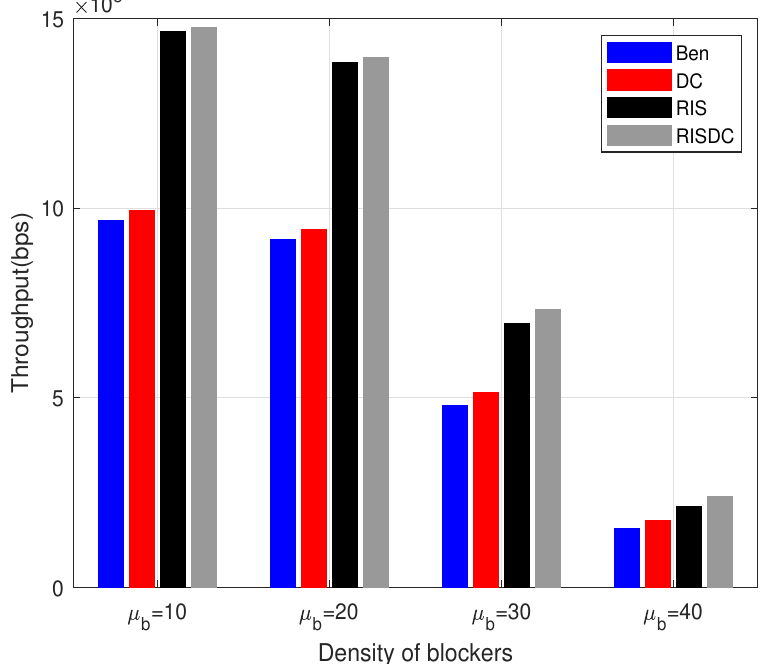
Figure 9. Variation of throughput with respect to blockage density µ b when ρ bs = 2, ρ user = 60, ρ ris = 6, and α =